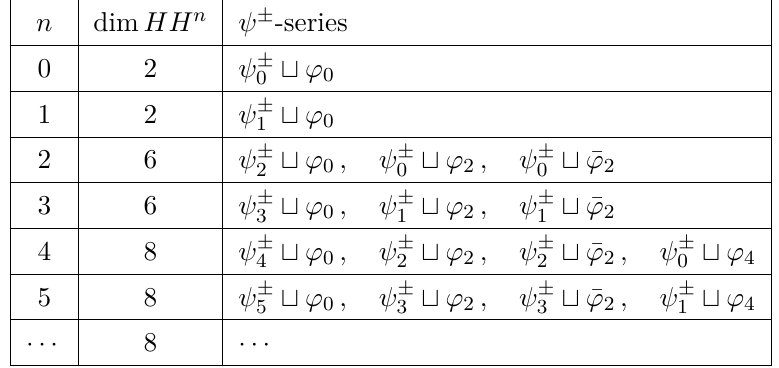
Table 5 . The basis cohomology classes of HH • ( A ⊗ Λ , A ⊗ Λ)